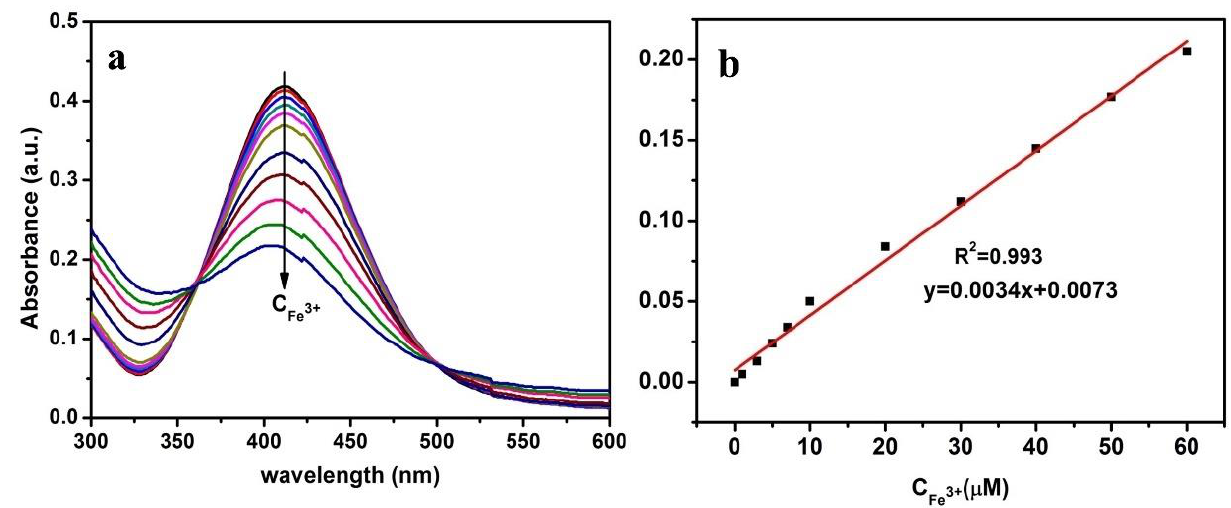
Figure 5. ( a ) UV – vis spectroscopy of the CMS/PVP-Ag NPs colloidal solution with different concen- trations of Fe 3+ , and ( b ) the linear relative absorption intensity ΔA over the concentration of Fe 3+ is within the range of 0~60 μM.